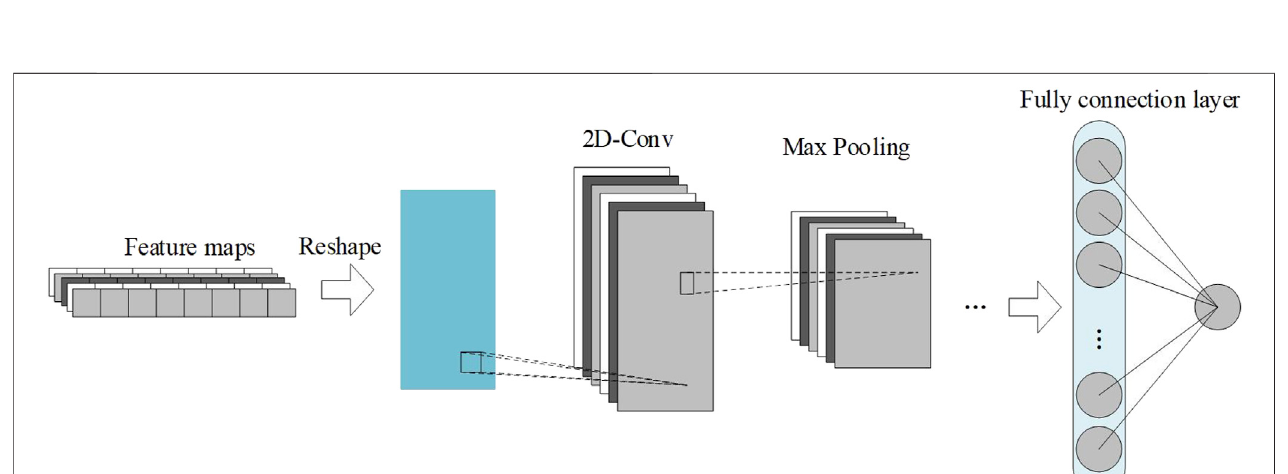
FIGURE 3 | The basic structure of 1D-CNN.